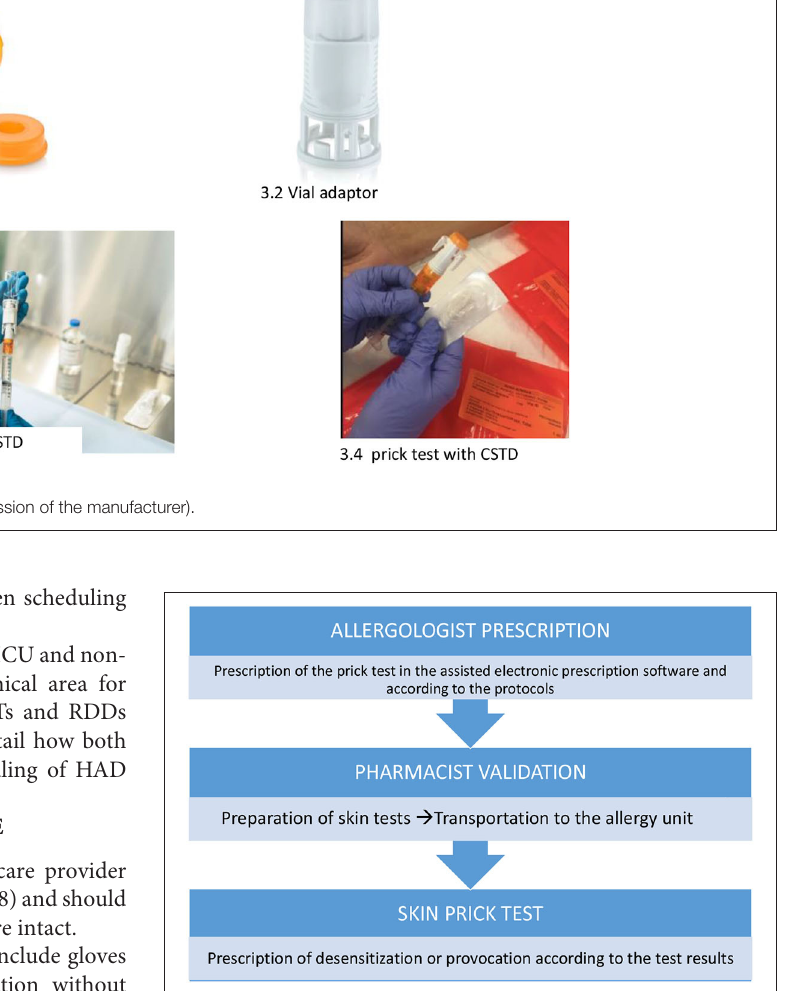
FIGURE 2 | Skin test